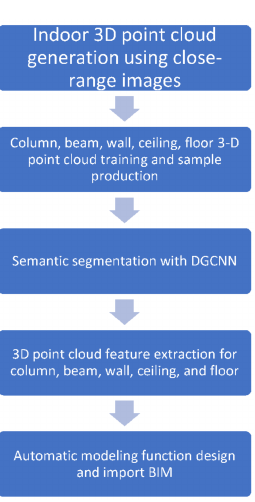
Figure 1. The overall process of the proposed method in this